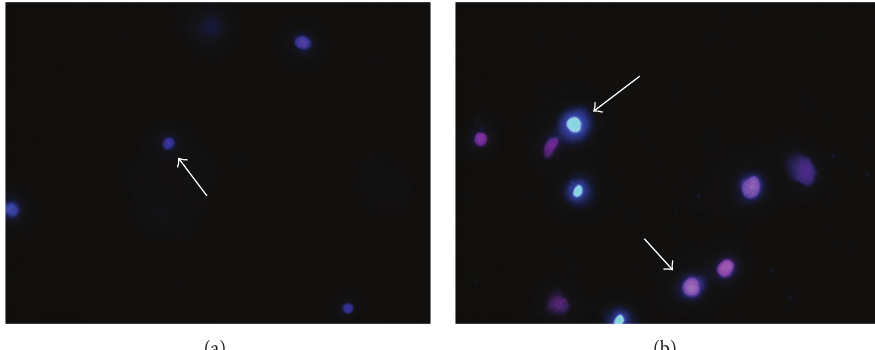
Figure 5: Apoptotic morphological changes in TFK-1 cells after treatment with sodium valproate. After 120h, untreated control group (a) and 2 mM sodium valproate-treated TFK-1 cells (b) were loaded with Hoechst 33342/PI and then observed via fluorescence microscopy (100x magnification). Mixture of low blue with low pink fluorescence indicates live cells ((a), short arrow), while high blue fluorescence indicates apoptotic cells ((b), long arrow), and pink represents dead cells ((b), short arrow).